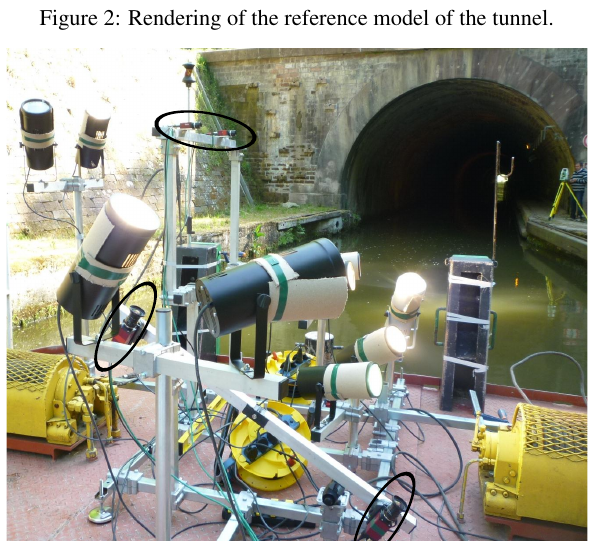
Figure 3: The inspection barge with the modular frame support- ing cameras and projectors entering Niderviller’s canal